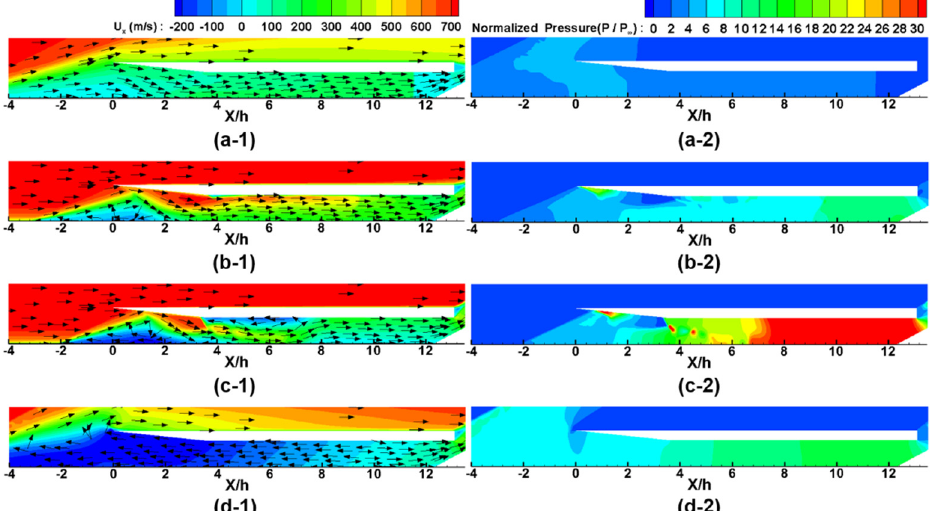
Figure 11. Axial velocity contours with the velocity vectors ( left ) and normalized pressure contours ( right ) for HAO mode: ( a-1 ) axial velocity at point [a]; ( a-2 ) normalized pressure at point [a]; ( b-1 ) axial velocity at point [b]; ( b-2 ) normalized pressure at point [b]; ( c-1 ) axial velocity at point [c]; ( c-2 ) normalized pressure at point [c]; ( d-1 ) axial velocity at point [d]; ( d-2 ) normalized pressure at point [d].